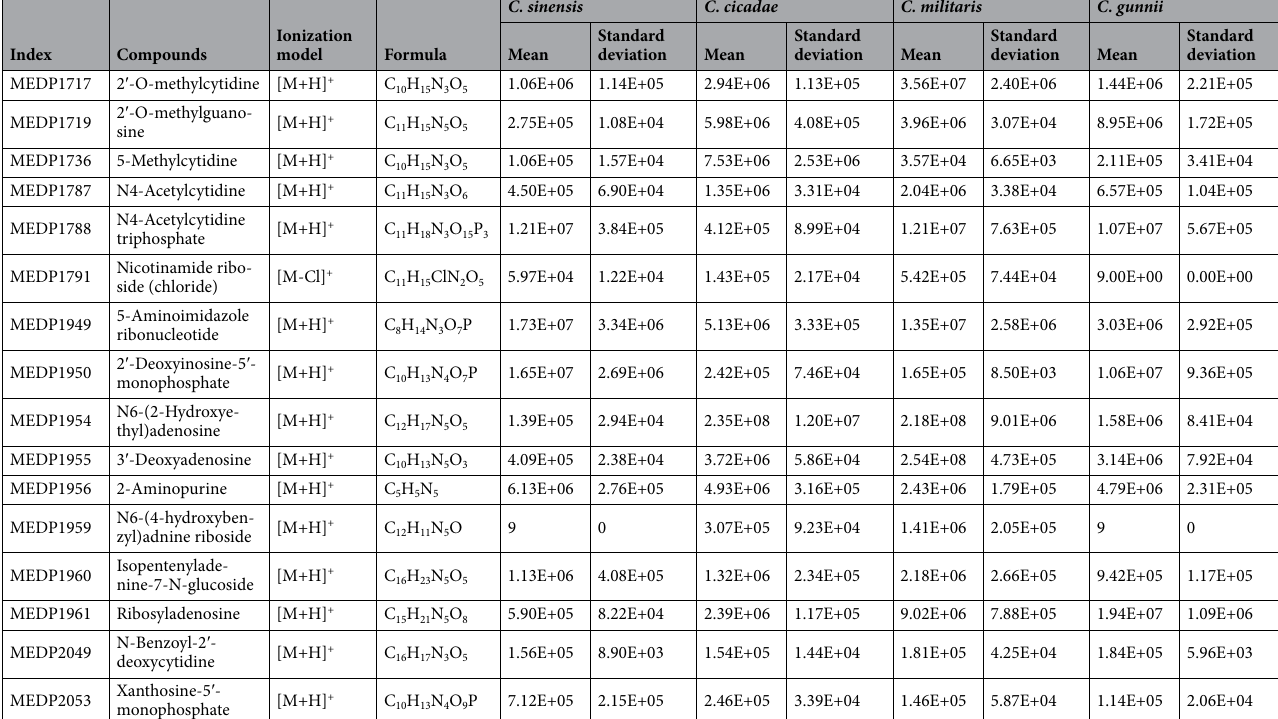
Table 1. Relative contents of nucleosides in C. sinensis , C. cicadae , C. militaris and C. gunnii were determined by